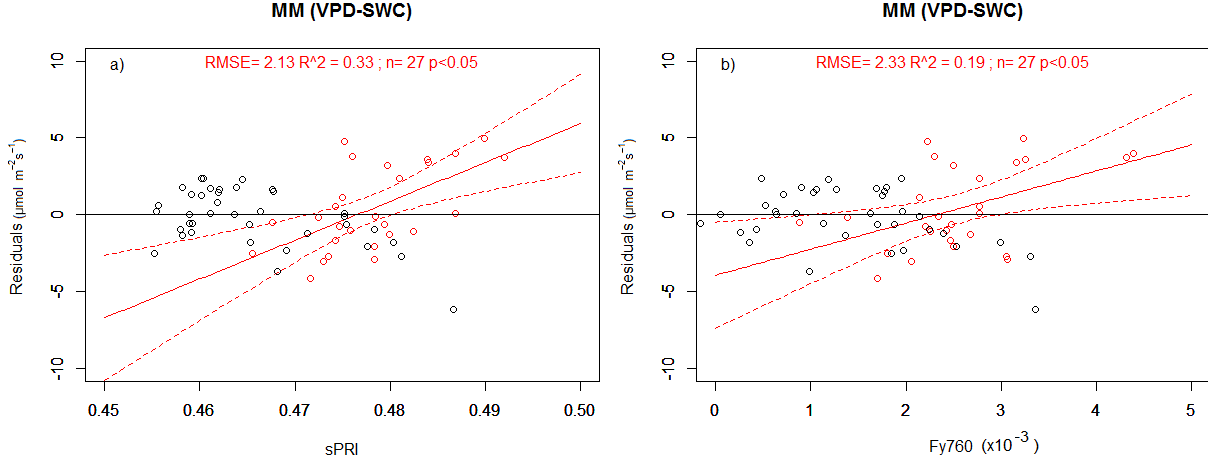
Figure 7. Correlation between residuals of the MM (VPD-SWC) model and (a) scaled photochemical reflectance index (sPRI) and (b) chlorophyll fluorescence yield (Fy760) taken from periods with high soil water content (SWC > 15%, red circles). No correlation was observed when SWC < 15% ( p > 0 . 5, black circles). Table 3. Results from the model evaluation leave-one-out cross-validation analysis across LUE model configurations and vegetation indices. Based on AIC cv , the best performance among formulation tests for each method is highlighted in bold. LUE model Variable RMSE r RMSE r 2 ME RMSE